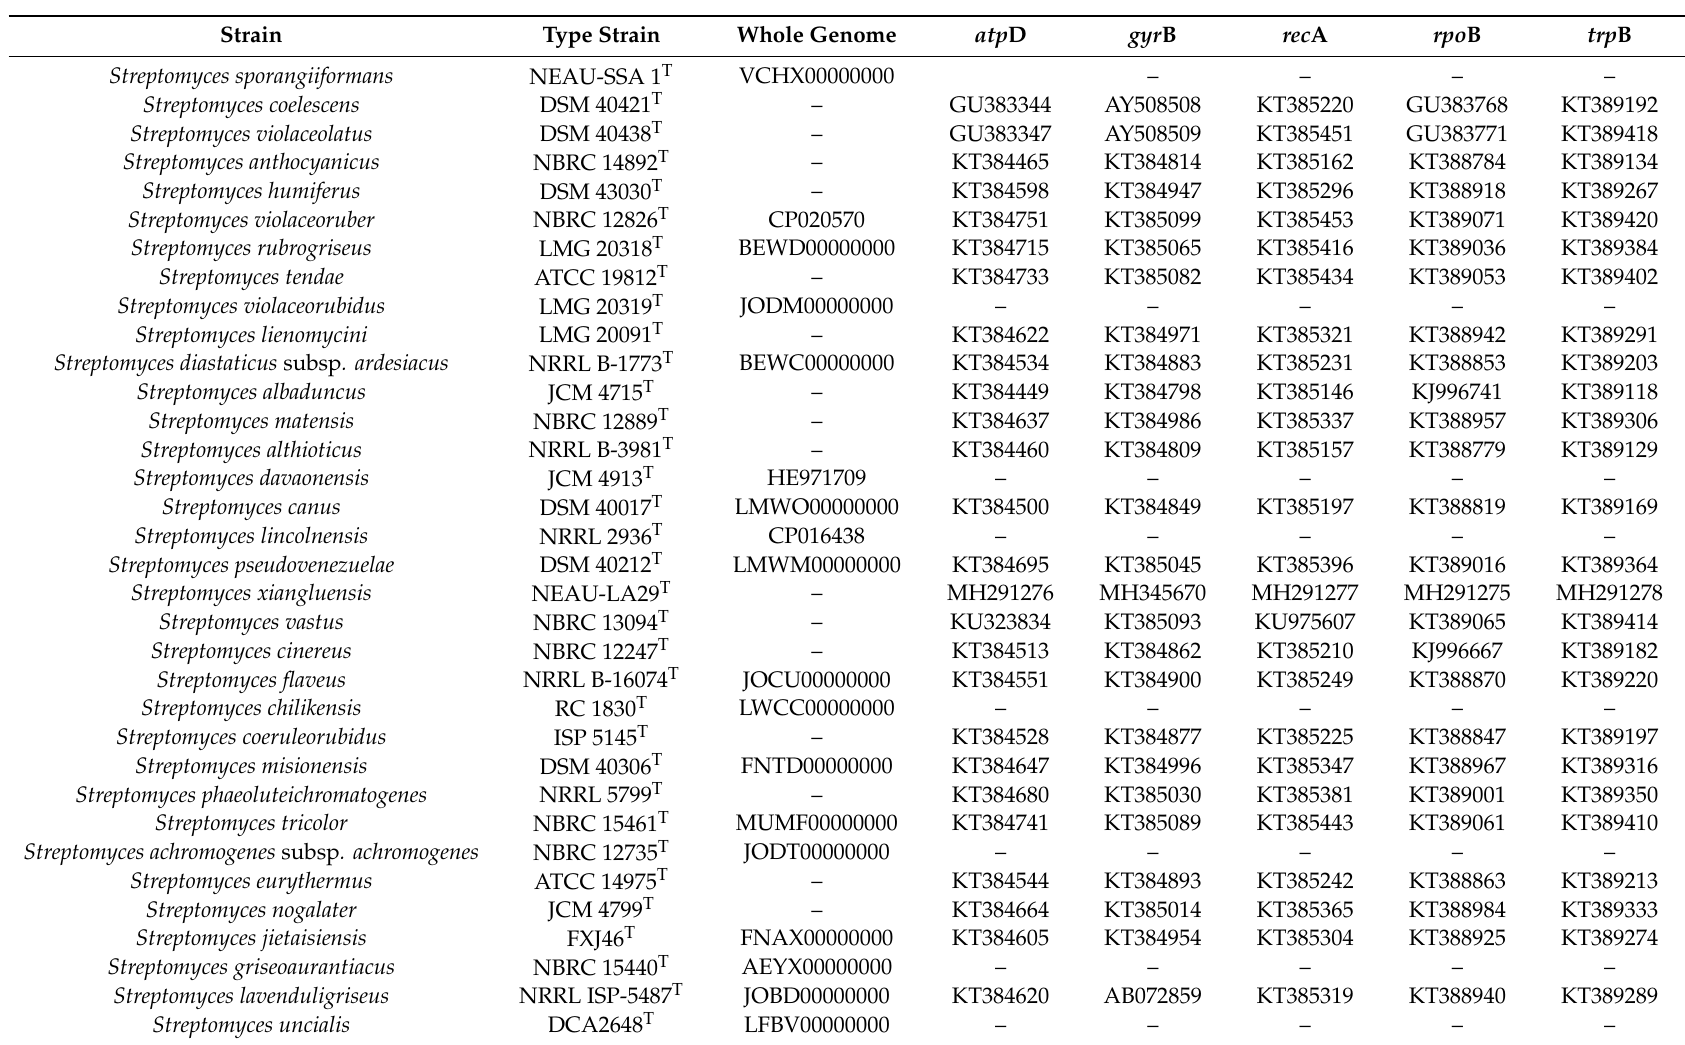
Table 1. GenBank Accession Numbers of the Sequences Used in